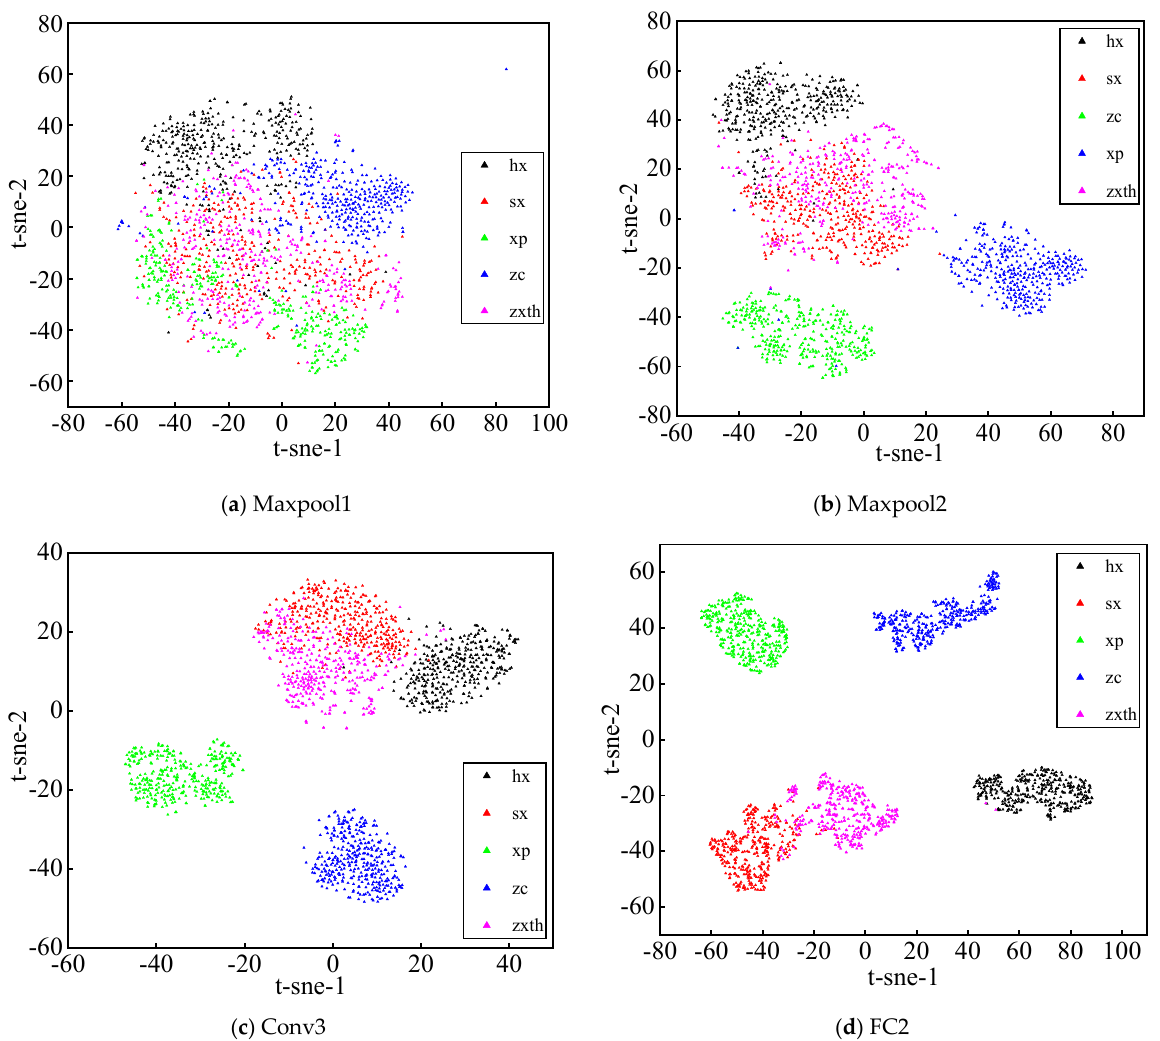
Figure 9. Visualization of t-distributed stochastic neighbor embedding (t-SNE). where, hx is the sliding slipper wear, sx is the loose slipper, xp is the swash plate fault, zc is the normal state, and zxth is the center spring failure.